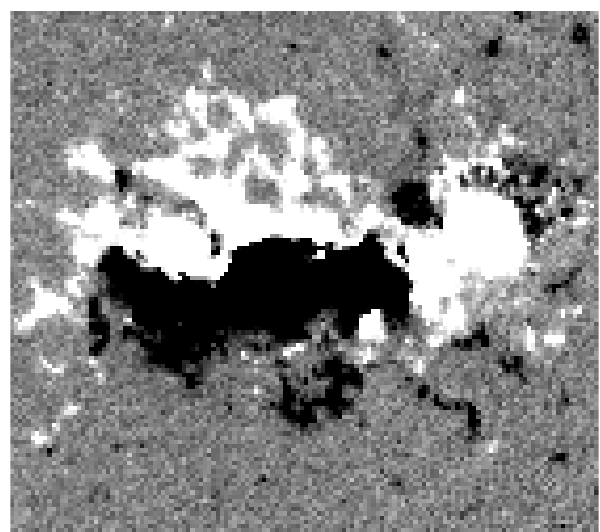
Fig. 9. A part of a SOHO/MDI magnetogram obtained at 17:35 UT on 7 November showing the NOAA AR